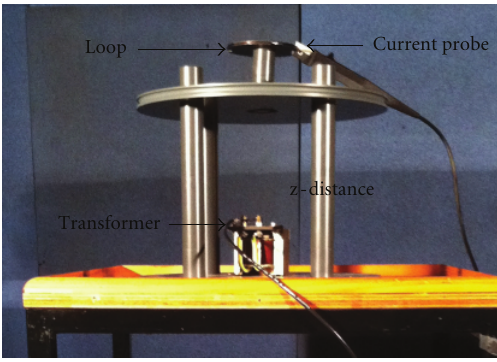
Figure 9: Mutual inductance